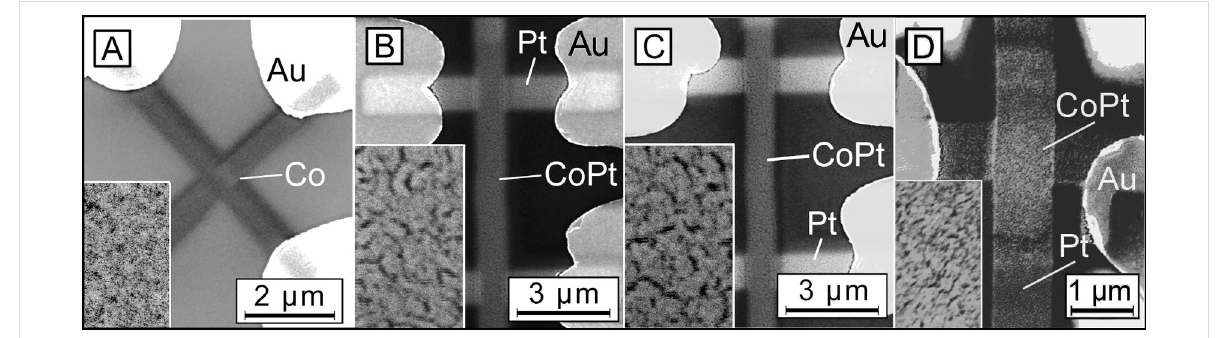
Figure 2: SEM images of the samples. The 500 × 860 nm 2 insets show the morphology of the post-processed Co/Pt FEBID nano-stripes in the middle of the overlap of the nano-stripes.